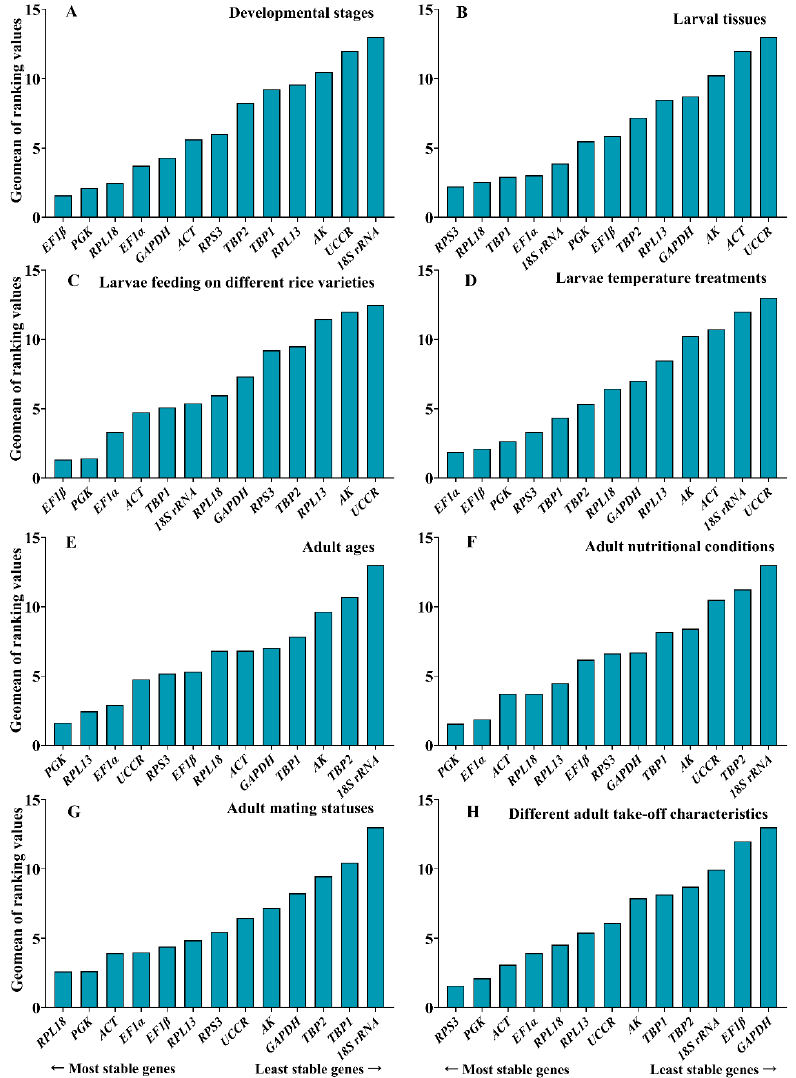
Figure 2. Expression stability of the candidate reference genes under eight experimental conditions calculated by RefFinder: ( A ) developmental stages; ( B ) larval tissues; ( C ) larvae feeding on different rice varieties; ( D ) larvae temperature treatments; ( E ) adult ages; ( F ) adult nutritional conditions; ( G ) adult mating statuses; ( H ) different adult take-off characteristics. A lower Geomean order indicated more stable